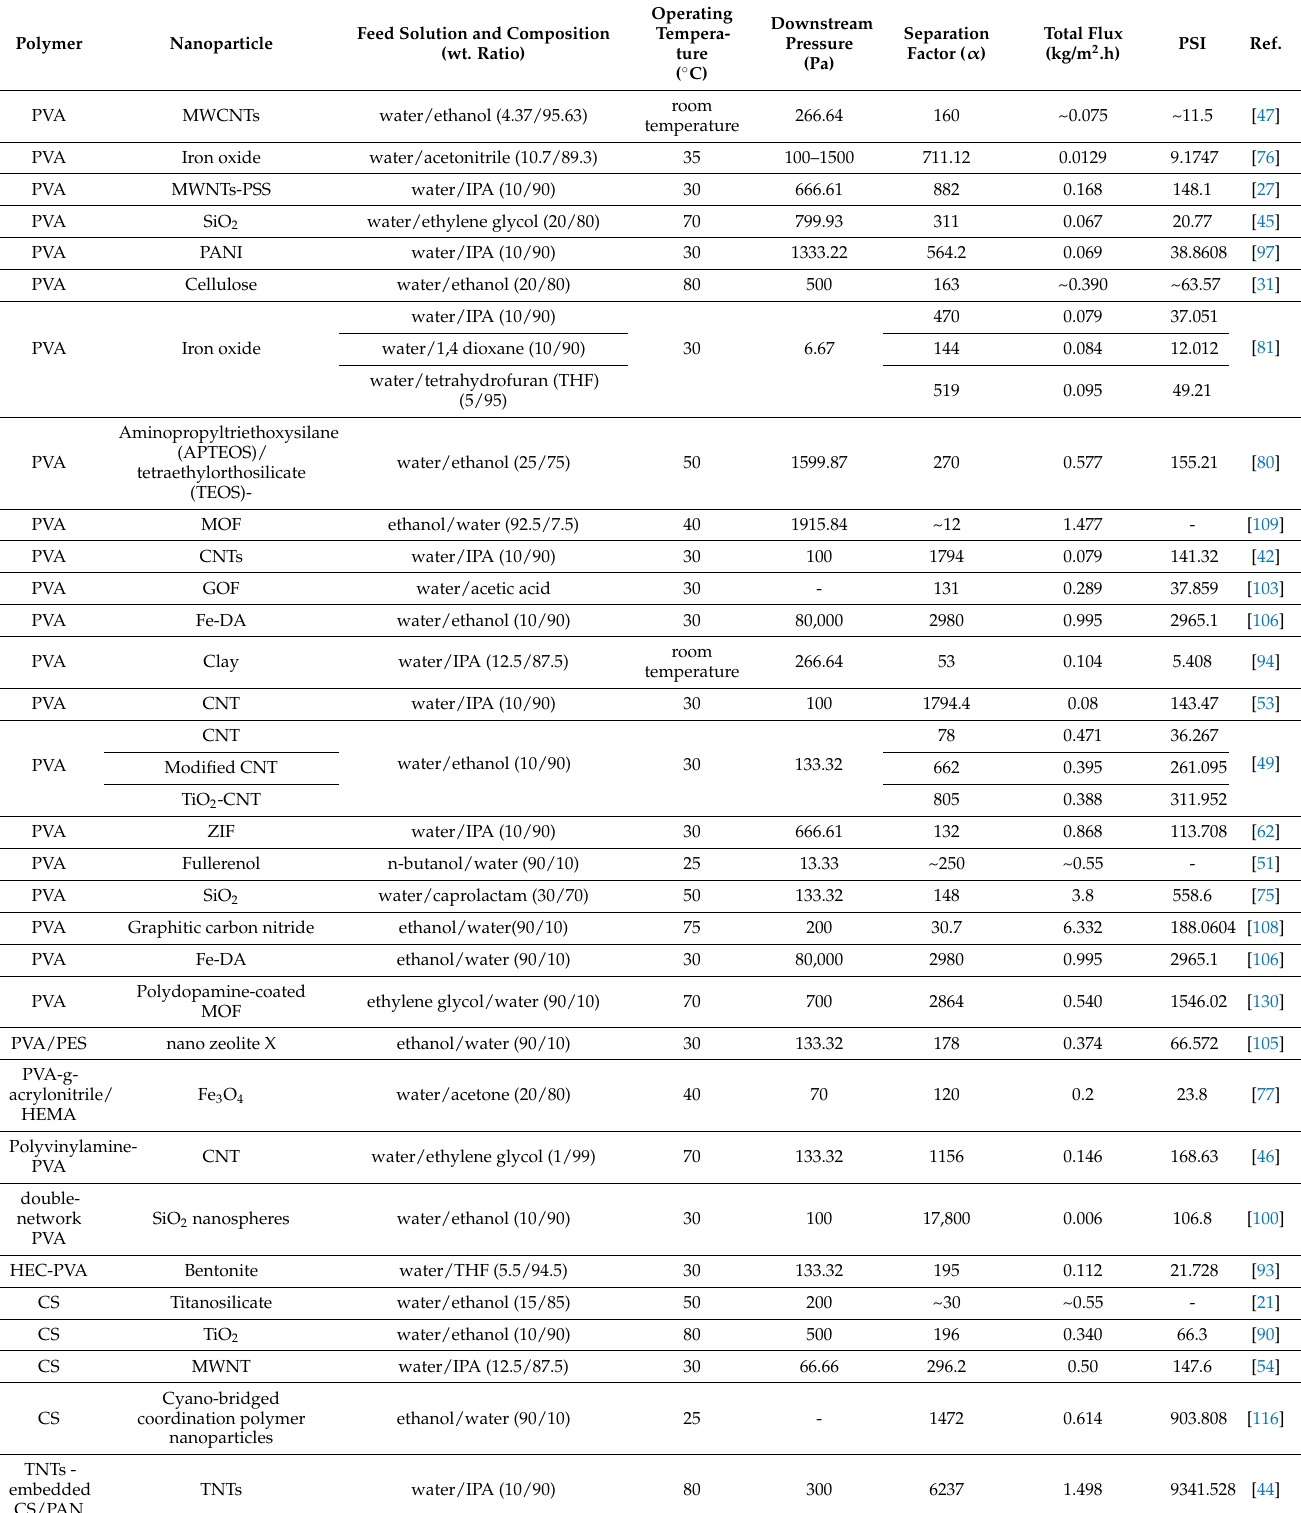
Table 7. PV performance of hydrophilic nanocomposite